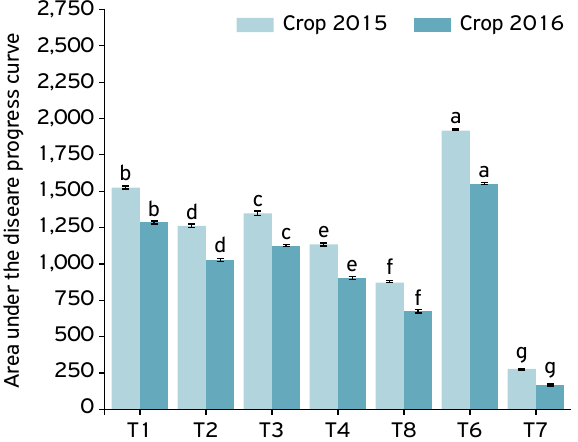
Figure 1. Area under the disease progression curve of the brown spot in the cultivar BRS Sabiá, field in Cedeteg Campus